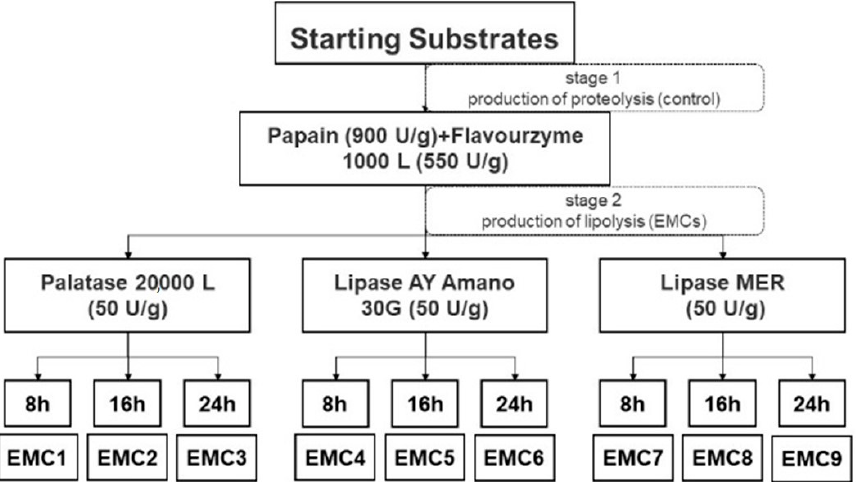
Figure 3. Process flow chart for the two-stage production of EMCs. Substrate: cheese slurry with- out enzyme hydrolyzed. Control: slurry hydrolyzed by Papain and